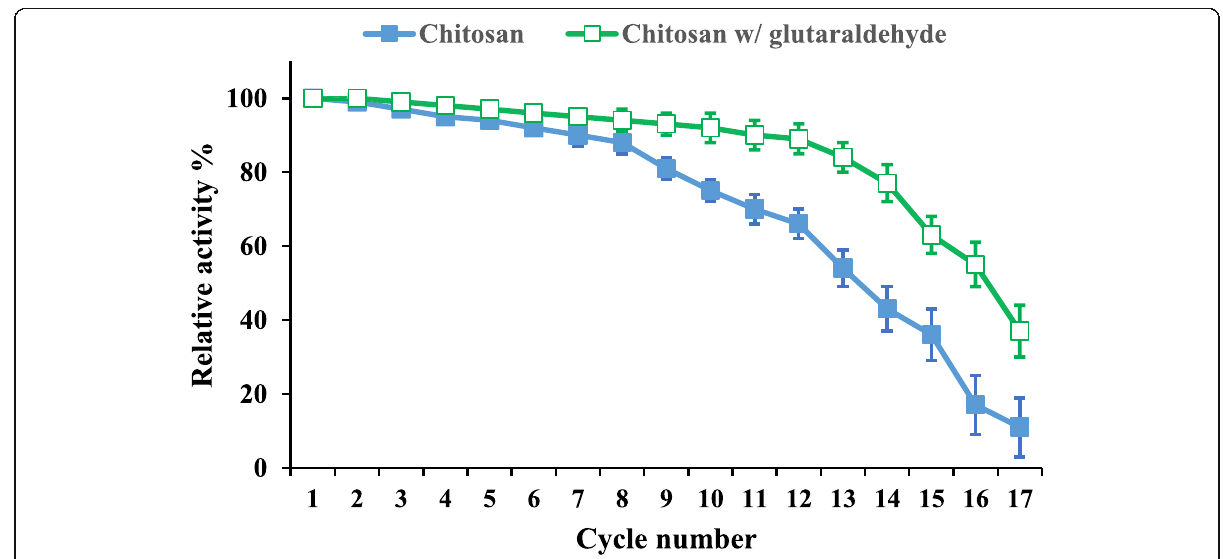
Fig. 7 Reusability of immobilized lipase with direct adsorption on chitosan beads and adsorption-crosslinking on chitosan with glutaraldehyde. Bars represent the standard